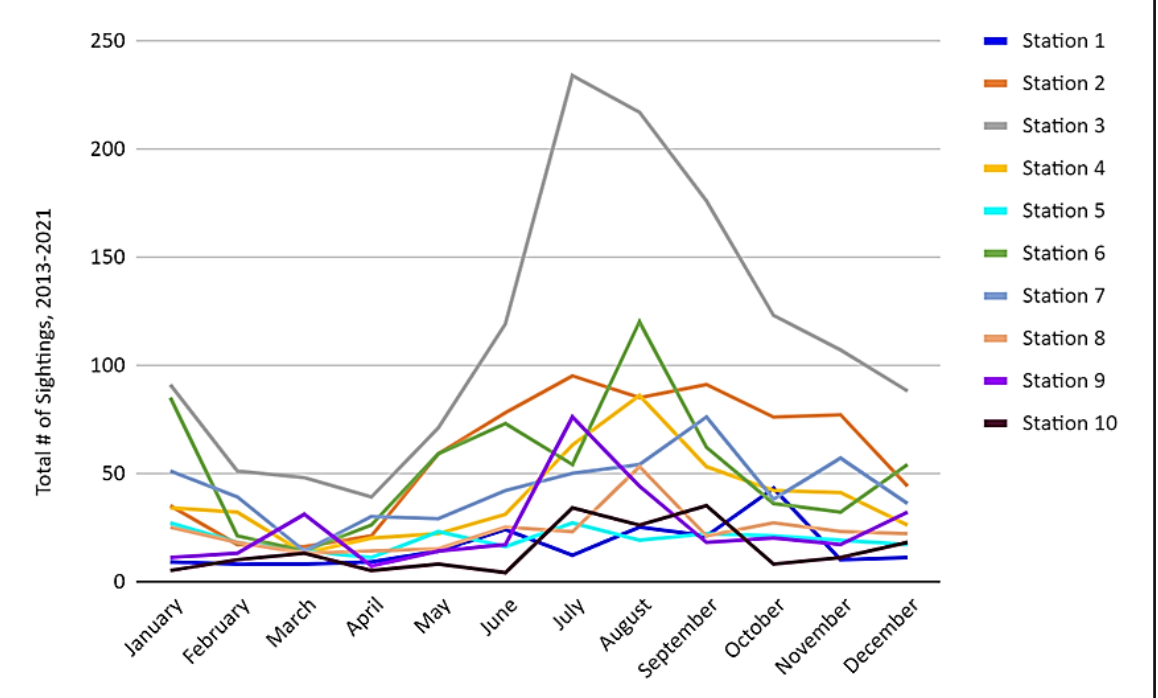
Figure 6. Sightings per Station by Month, 2013–2021.